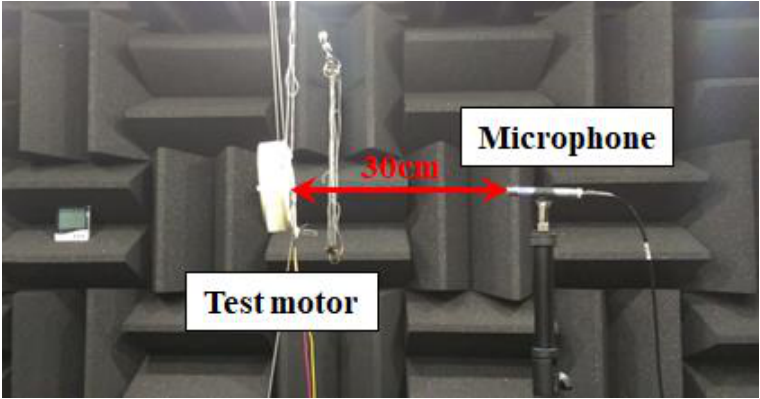
Figure 22. Experimental environment.